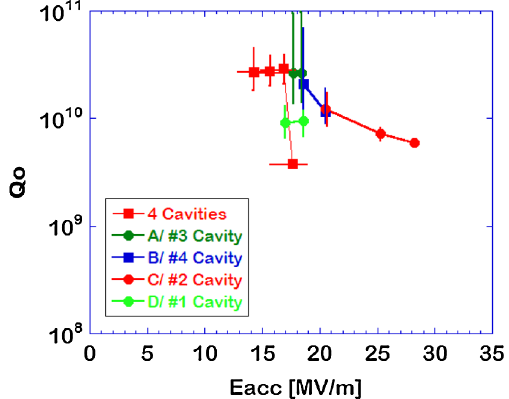
FIG. 27. (Color) Unloaded Q values ( Q o ) calculated from the results of dynamic rf loss measurement at 2